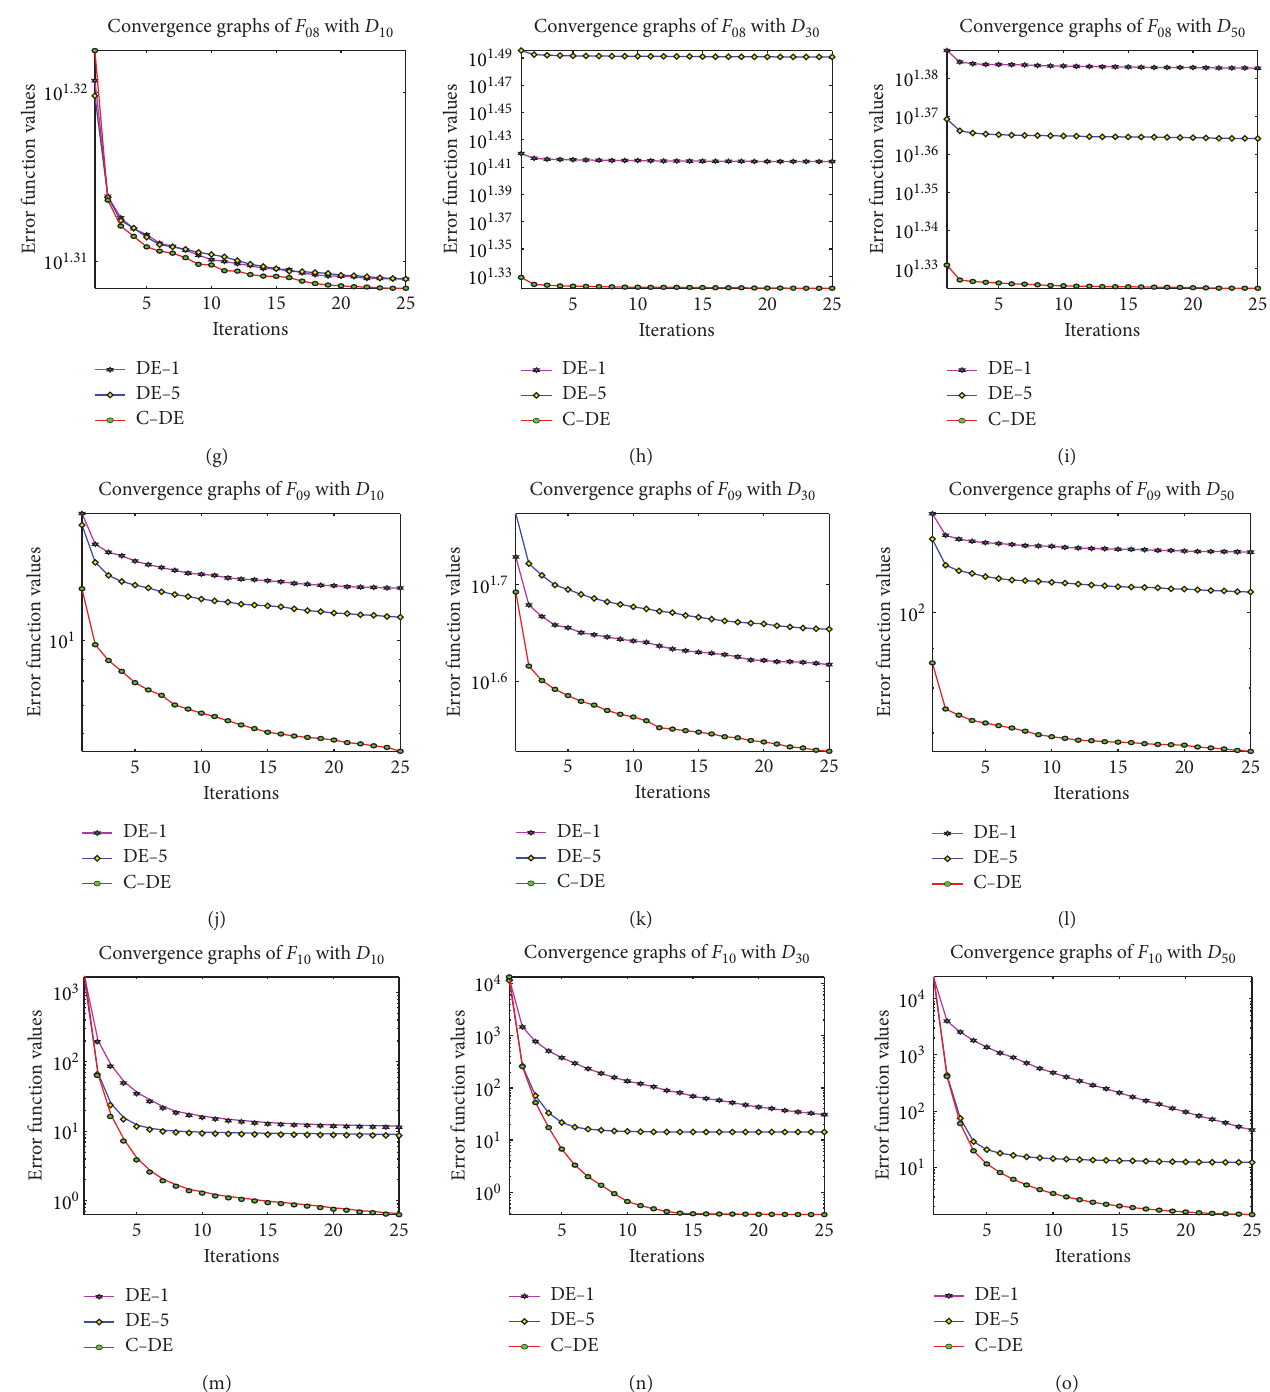
Figure 3: Evolution in the best function values of F